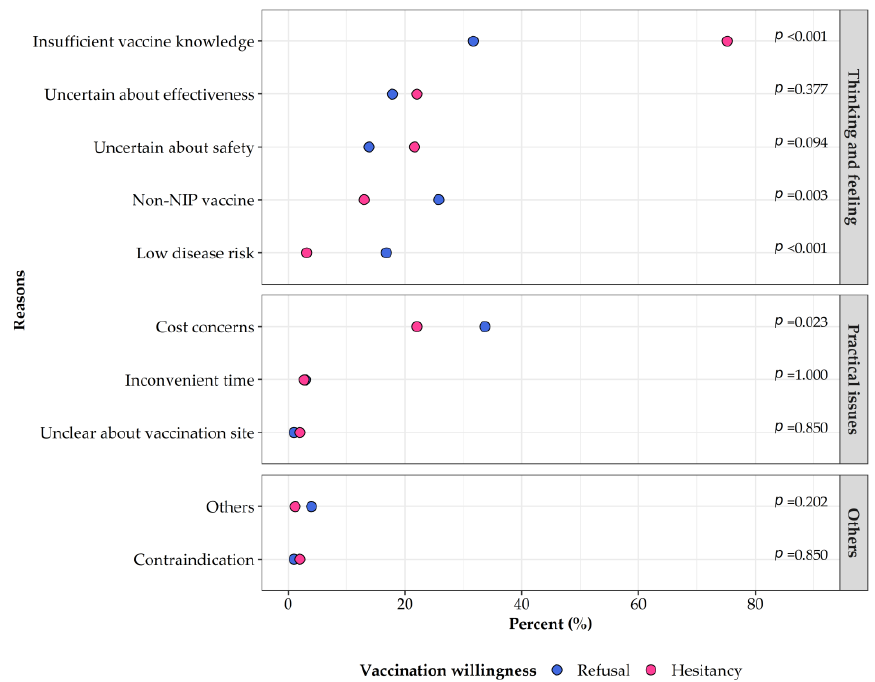
Figure 1. Reasons for refusal and hesitancy about getting children vaccinated with 13-valent pneu- mococcal conjugate vaccines. NIP is the abbreviation for National Immunization Program.